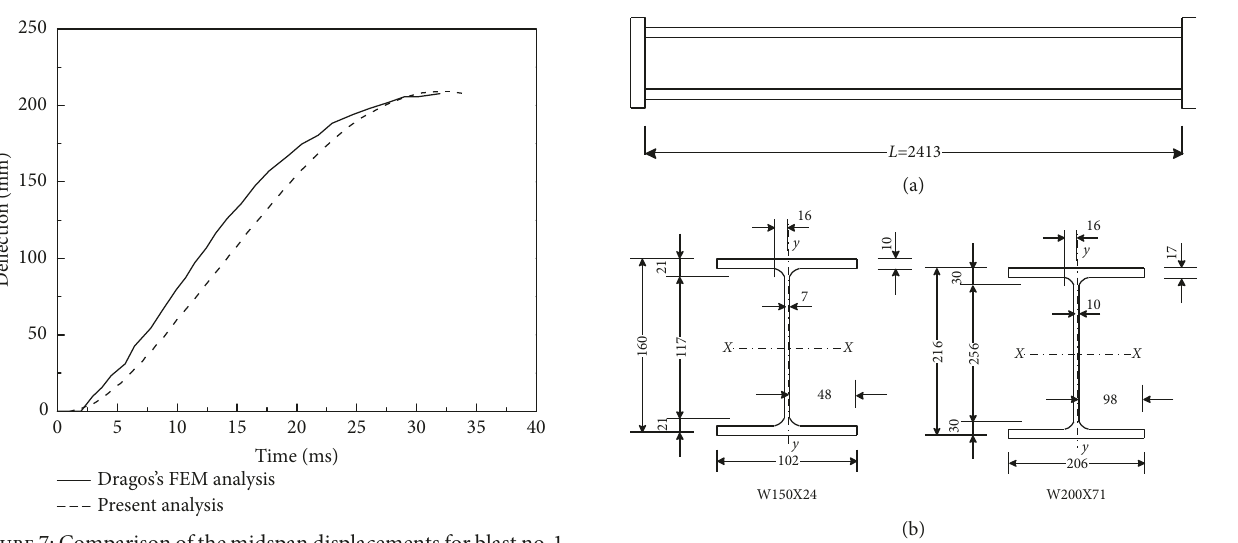
Figure 9: (a) Test specimens and (b) cross sections of the test